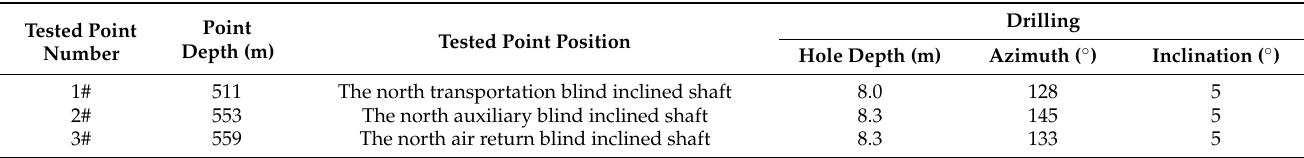
Table 1. Technical characteristics of the in-situ stress-tested point in the 106 mining area.